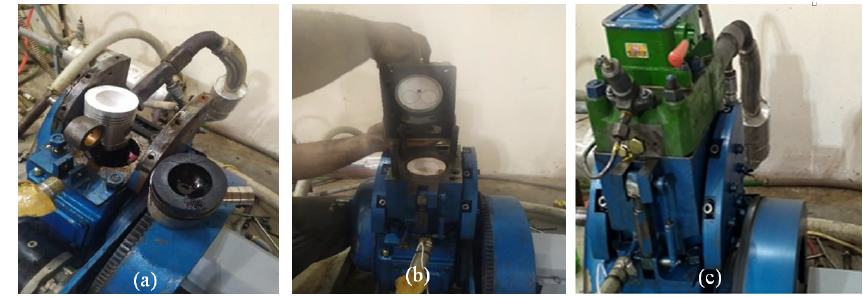
Figure 5: Single cylinder diesel engine rig test (a) Piston set up, (b) Head of cylinder and (c) Rig test after setup spare parts